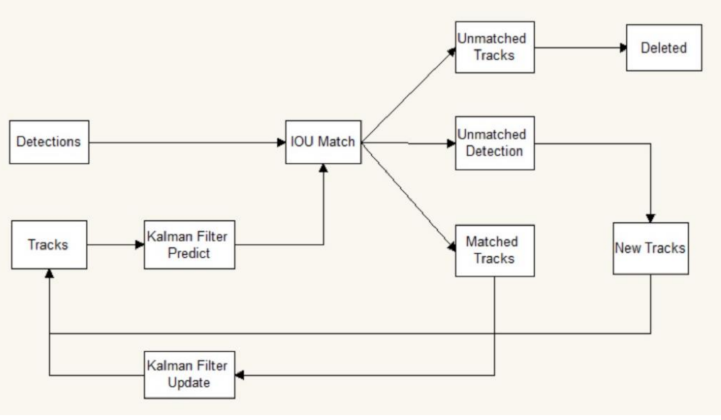
Figure 1. Object tracking procedure of SORT [14]. DeepSORT was developed from SORT. Information about the exterior of the objects was added in order to match objects in adjacent frames. The procedure of DeepSORT is as follows: first, the Kalman filter is used to predict the trajectory. Then, the Hungarian algorithm is used to match the predicted trajectory with the detections in the current frame (cascade matching and IOU matching). Thereafter, the Kalman filter is updated. DeepSORT can be applied in Multiple Object Tracking (MOT), which can assign each vehicle with different IDs. The object tracking procedure of DeepSORT is shown in Figure 2.